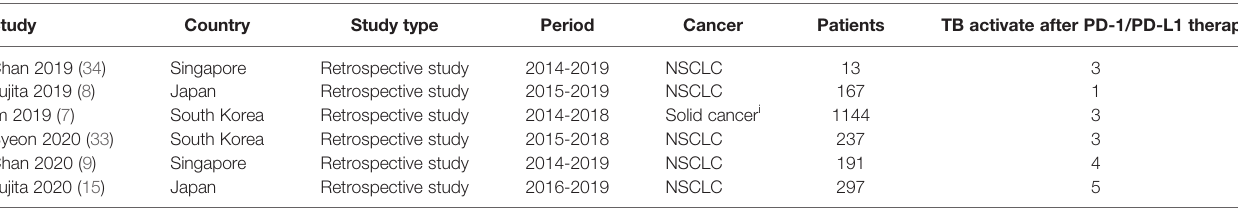
TABLE 4 | Characteristics of study population in the 6 retrospective studies with prediction models for TB incidence.